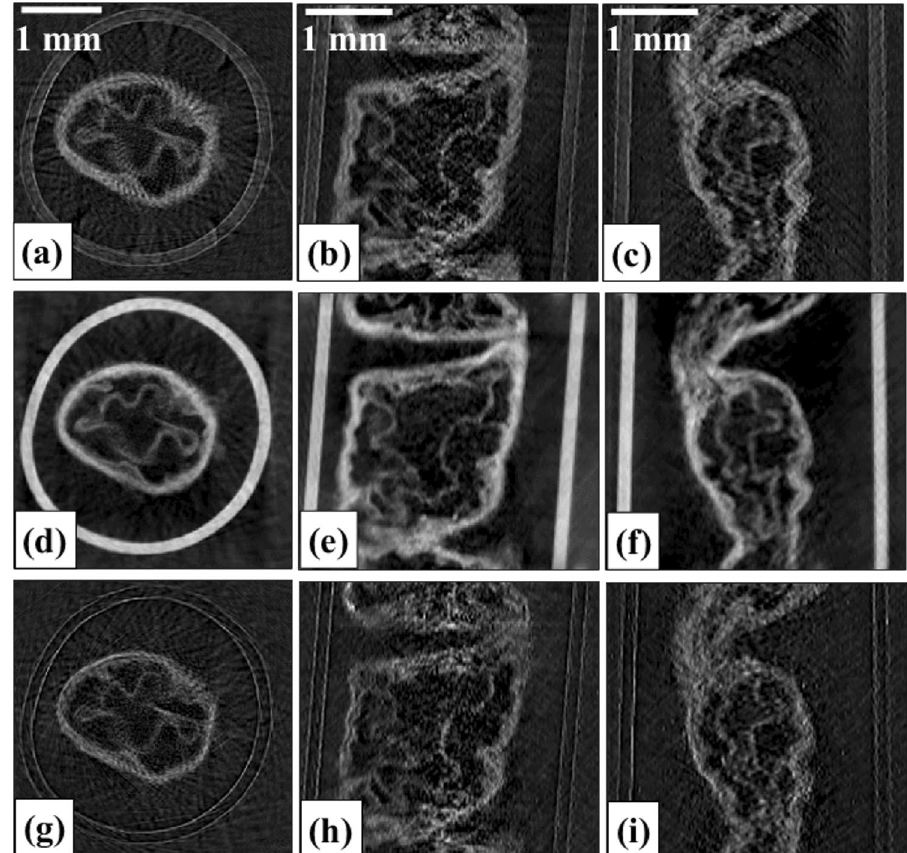
Figure 4. Reconstructed ( a – c ) attenuation, ( d – f ) phase, and ( g – i ) scattering, ( a , d , g ) axial, ( b , e , h ) sagittal, and ( c , f , i ) coronal